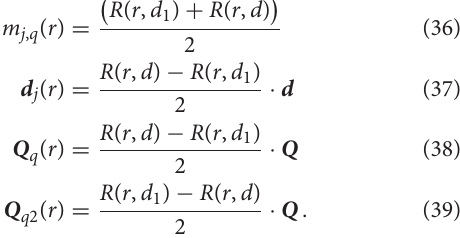
Frontiers in Physics |